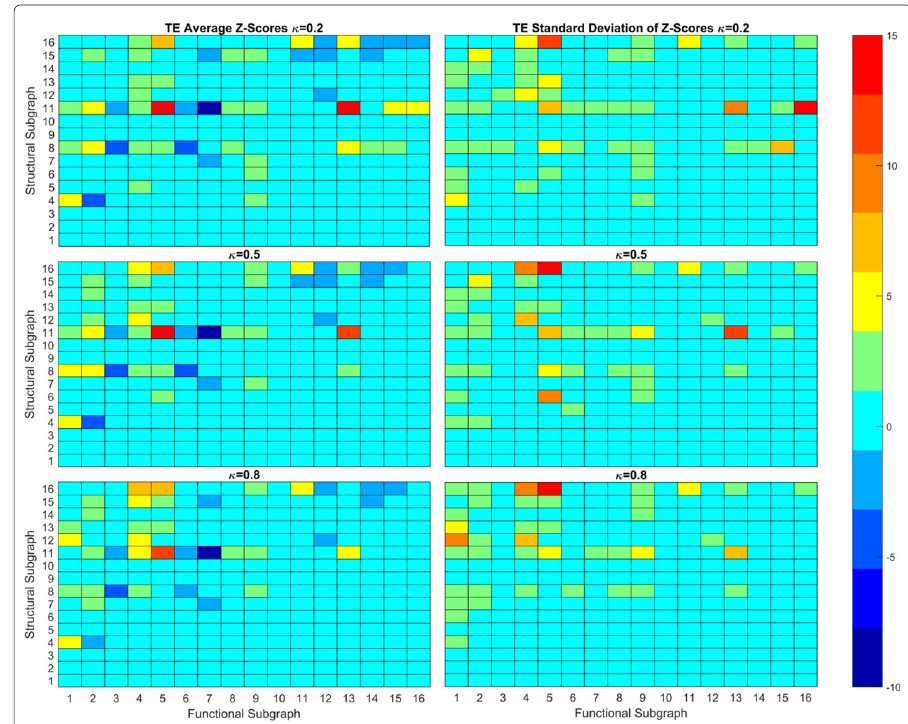
Fig. 8 Average and Standard Deviation of Z-Scores for TE. Heatmap of average and standard deviation Z-scores of triadic subgraphs for TE reconstruction. The anti-diagonal consists of preservation transformations while off anti-diagonal are conversion transformations. The lower right triangle consists primarily of FP transformations while the upper left triangle consists primarily of FN transformations